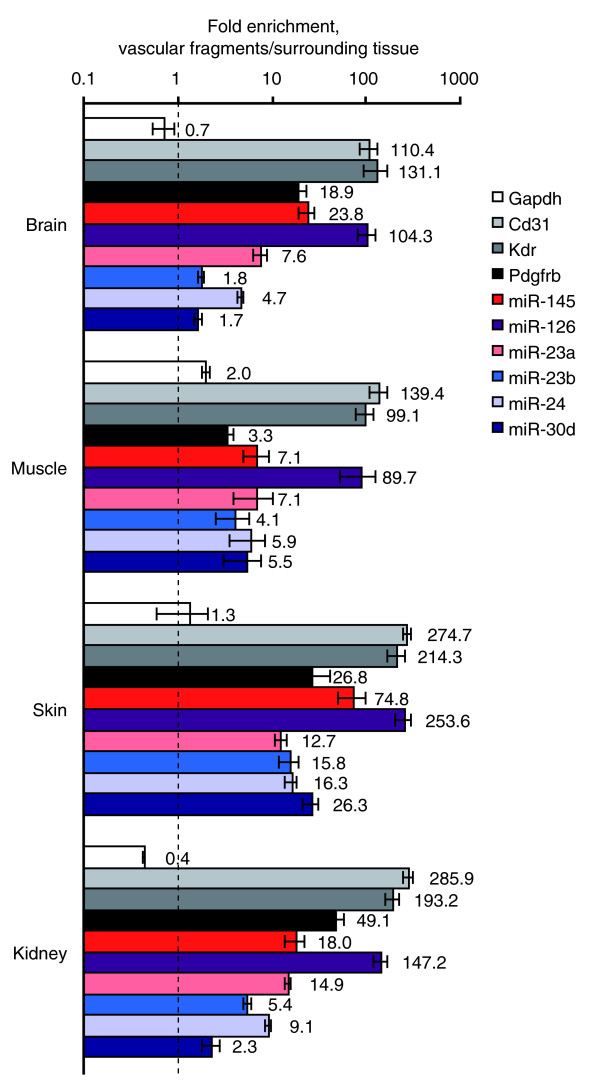
Differential expression of miRNAs in CD31+ vascular fragments isolated from mature mouse organs. Anti-CD31-coated magnetic beads were used to isolate microvascular fragments from adult (8 weeks) C57Bl/6 mouse organs. cDNA was prepared from the fragments and the remaining tissue using equal amounts of RNA, and miR-145 expression levels were determined using TaqMan qRT-PCR. The figure shows average paired expression ratios between fragments and surrounding tissue ± standard error of the mean (n = 4, 3, 2 and 4 for brain, muscle, skin and kidney, respectively). GAPDH, CD31 and VEGFR-2 (Flk1) TaqMan assays were used as quality controls.